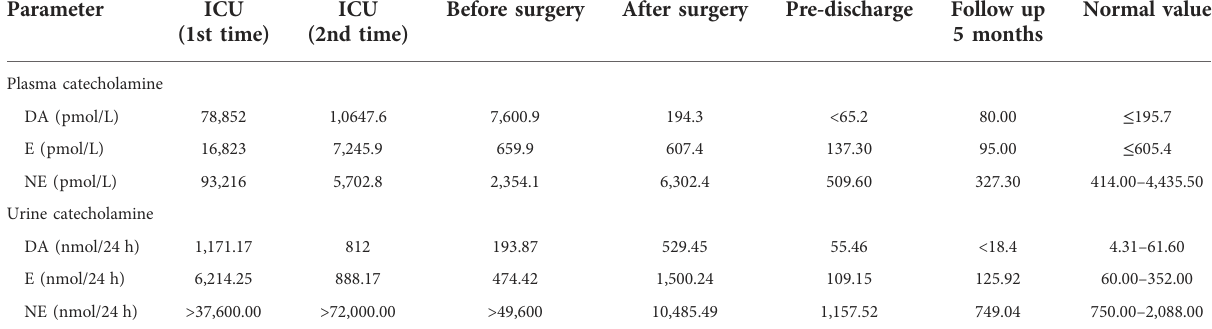
TABLE 1 Plasma and urine catecholamine in the timeline. Parameter Before surgery After surgery